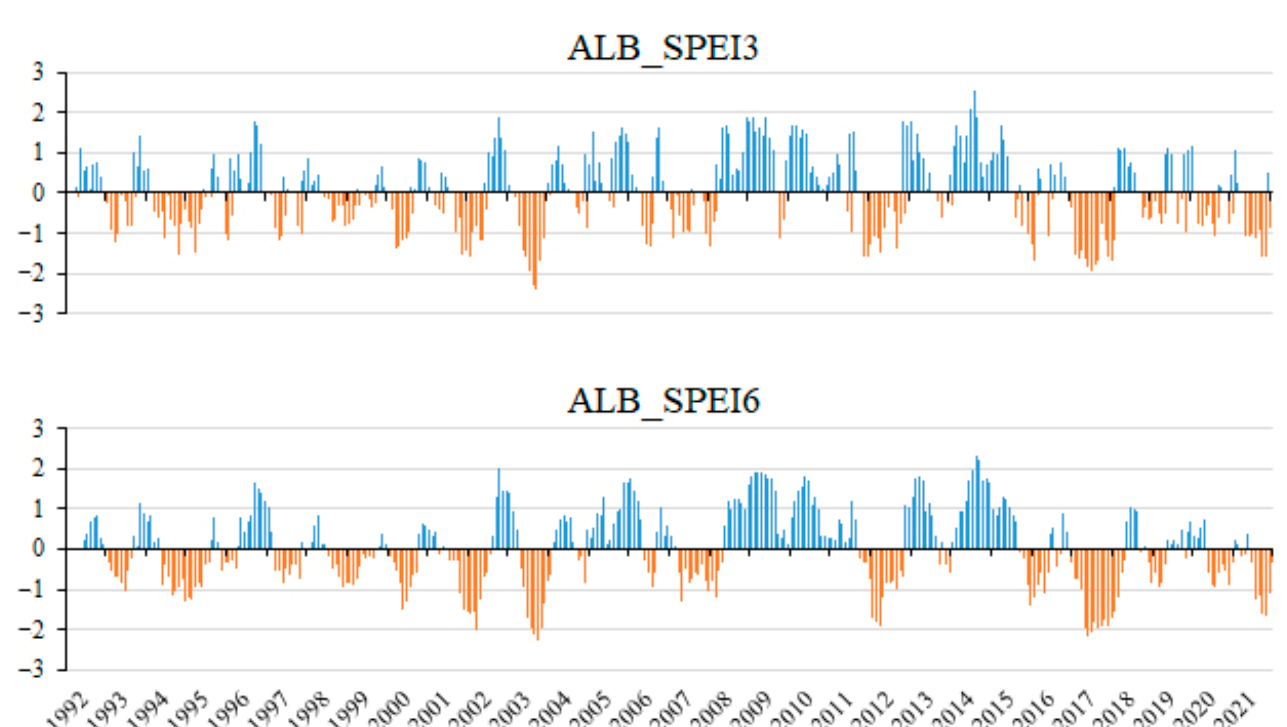
Figure 4. Long term standardized precipitation-evapotranspiration index (SPEI) calculated at ALB on 3- and 6-month basis. For each year, blue and red bars represent, respectively, monthly positive and negative SPEI values.